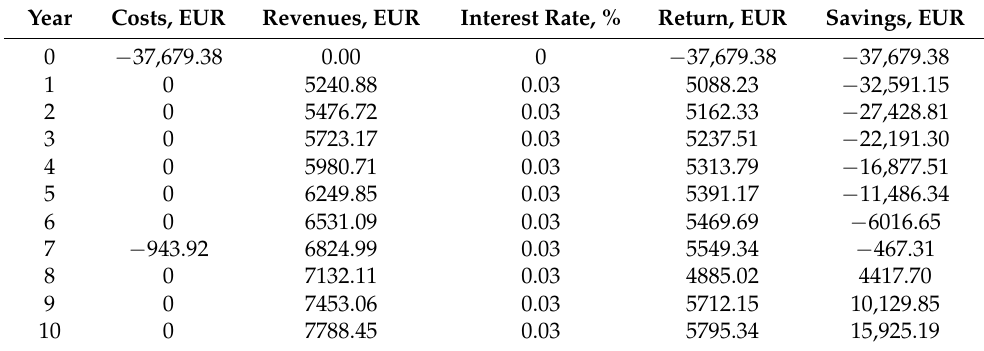
Table 2. An economic evaluation of the investment into the solar system.